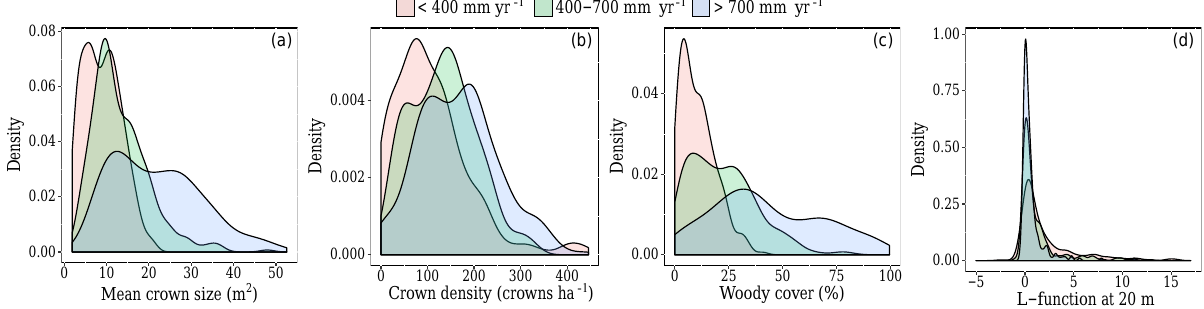
Figure 5. Frequency distributions of mean crown size, crown density, woody cover and aggregation calculated for different MAP ranges.